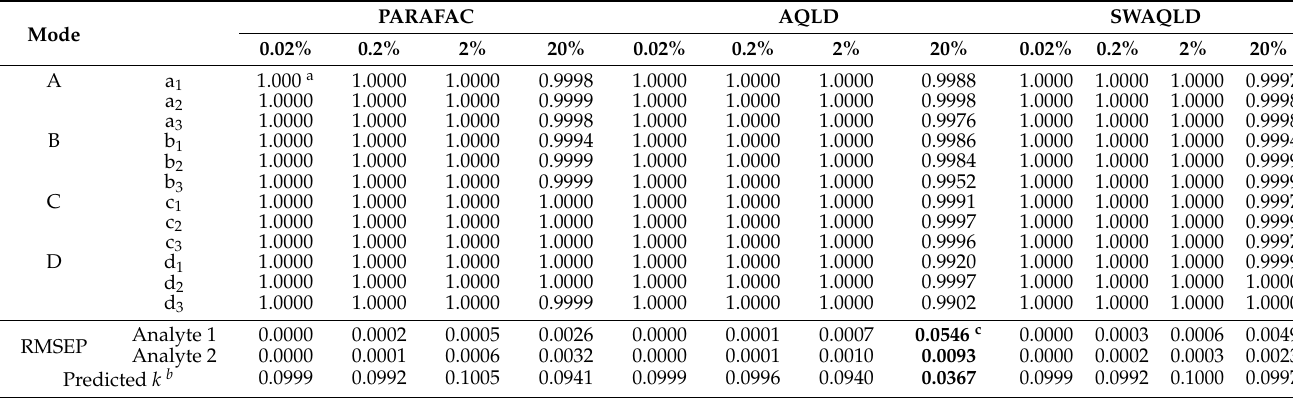
Table 4. The influence of homoscedastic noise levels ( A homo ) on correlation coefficients, RMSEPs, and k values predicted by PARAFAC, AQLD, and SWAQLD, respectively, for simulated four-way data.